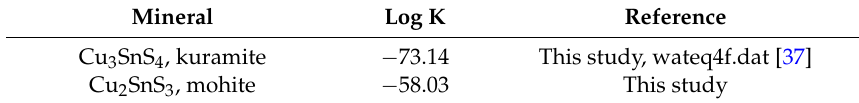
Table 2. Calculated log K for the dissolution reactions of the ternary species considered in this